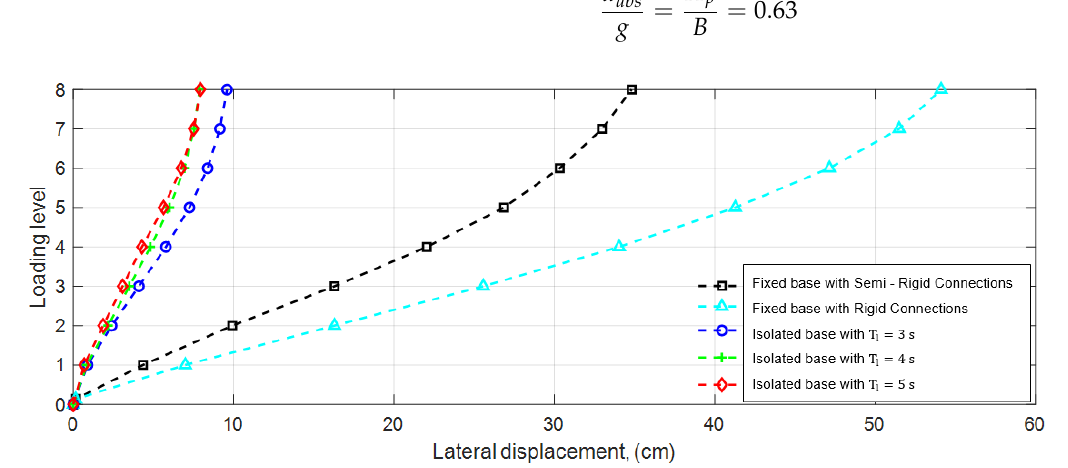
Figure 12. Lateral displacement of the load levels of 8-level racks with fixed support at the base and with base isolation.